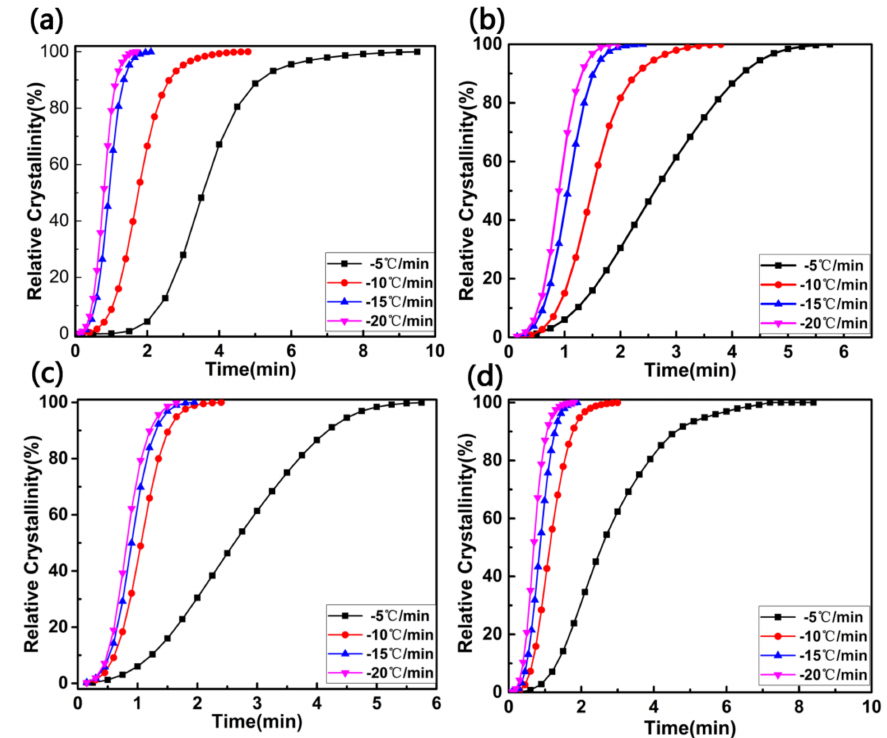
Figure 9. Plots of relative degree of crystallinity (X t ) versus crystallization time (t) for ( a ) PET; ( b ) PET/PET-3; ( c ) PET/PET-4 and ( d ) PET/PET-5 at different cooling